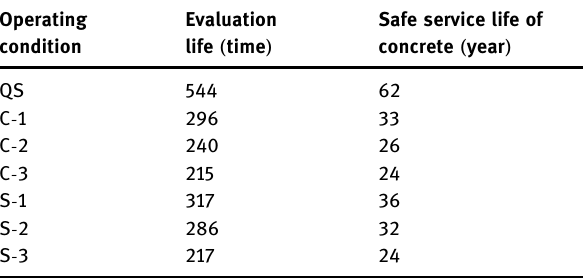
Table 10: Evaluation life and safe service life of concrete in the